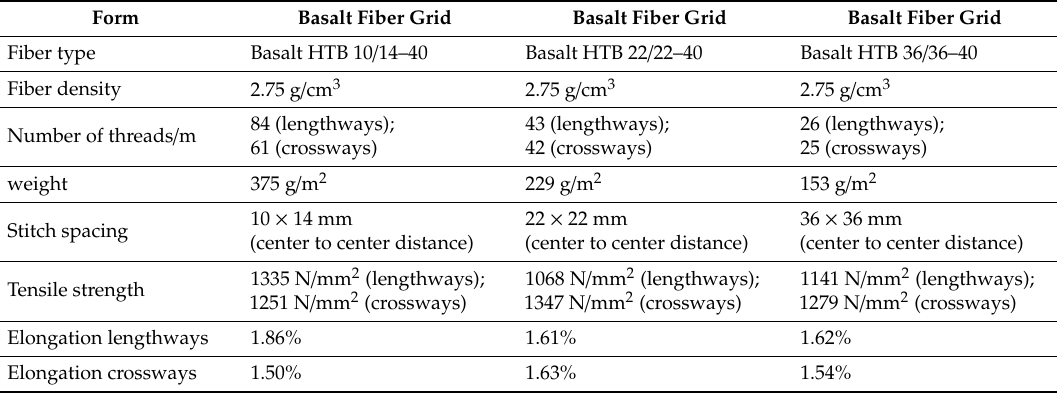
Figure 1. Image of basalt fiber meshes and chopped basalt fiber. Table 1. Properties of the three various types of basalt textile provided by manufacturer.